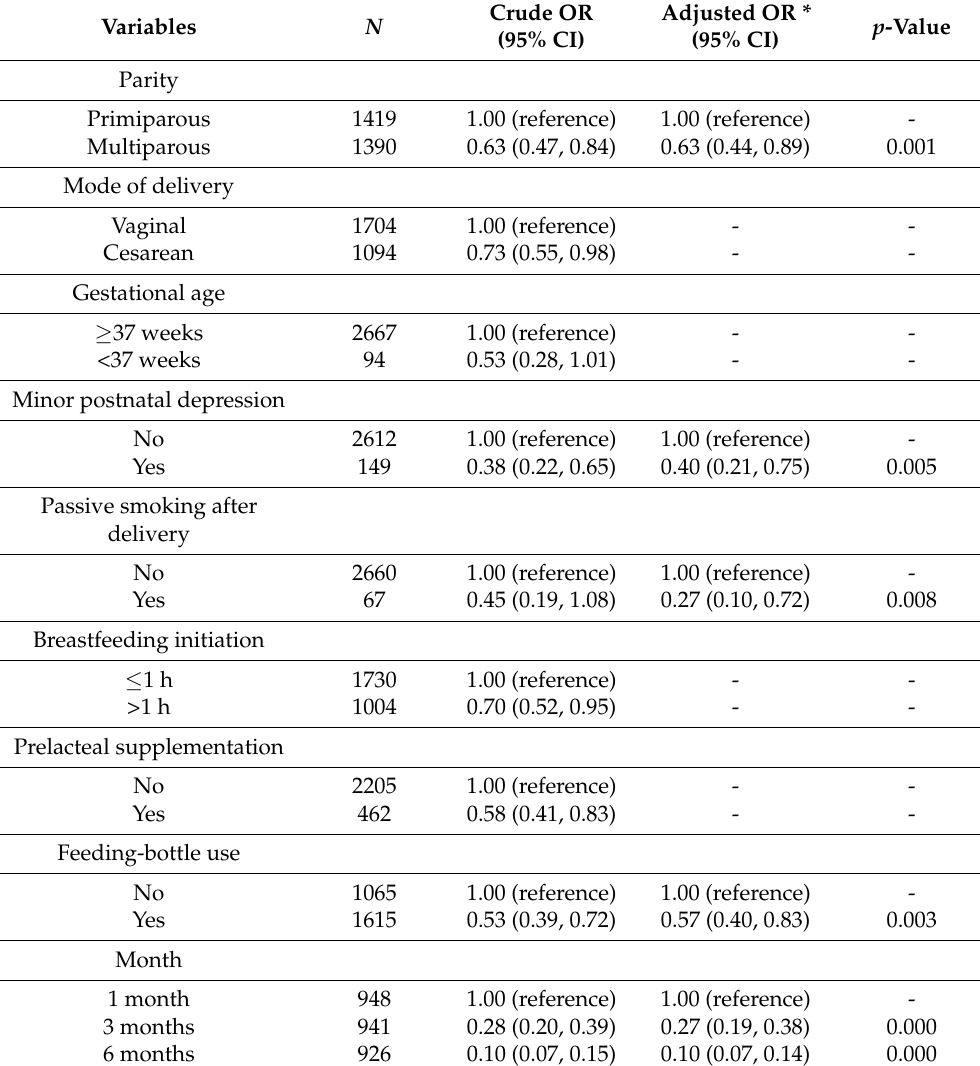
Table 4. Modifiable individual factors affecting any breastfeeding (ABF).